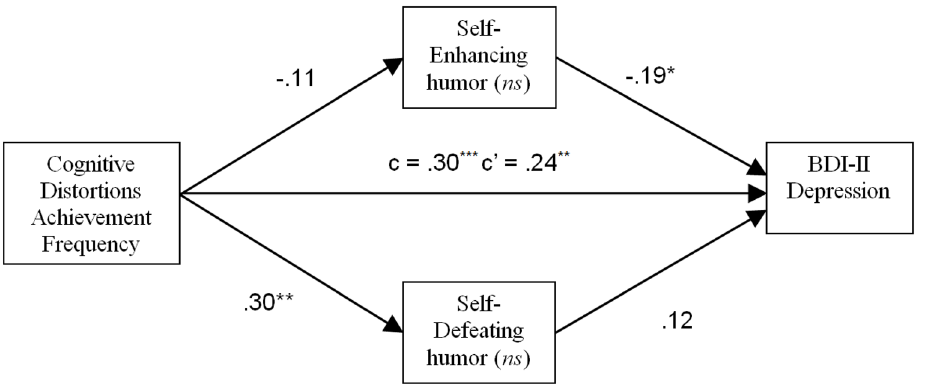
Figure 3. Nonsignificant mediating effect of humor styles on the relation between frequency of cognitive distortions in achievement contexts and depressive symptoms.